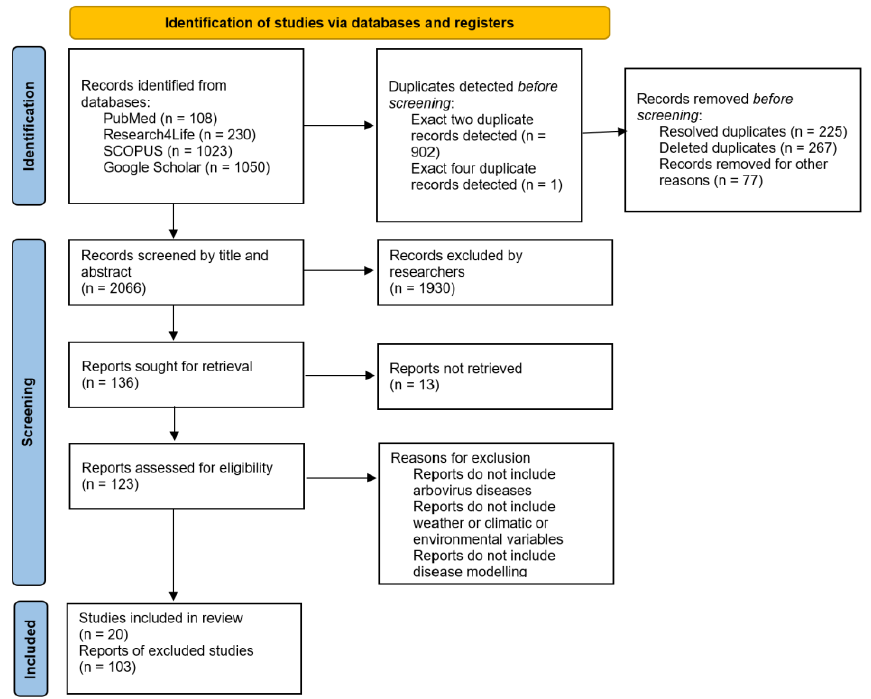
Figure 2. The PRISMA flow diagram.